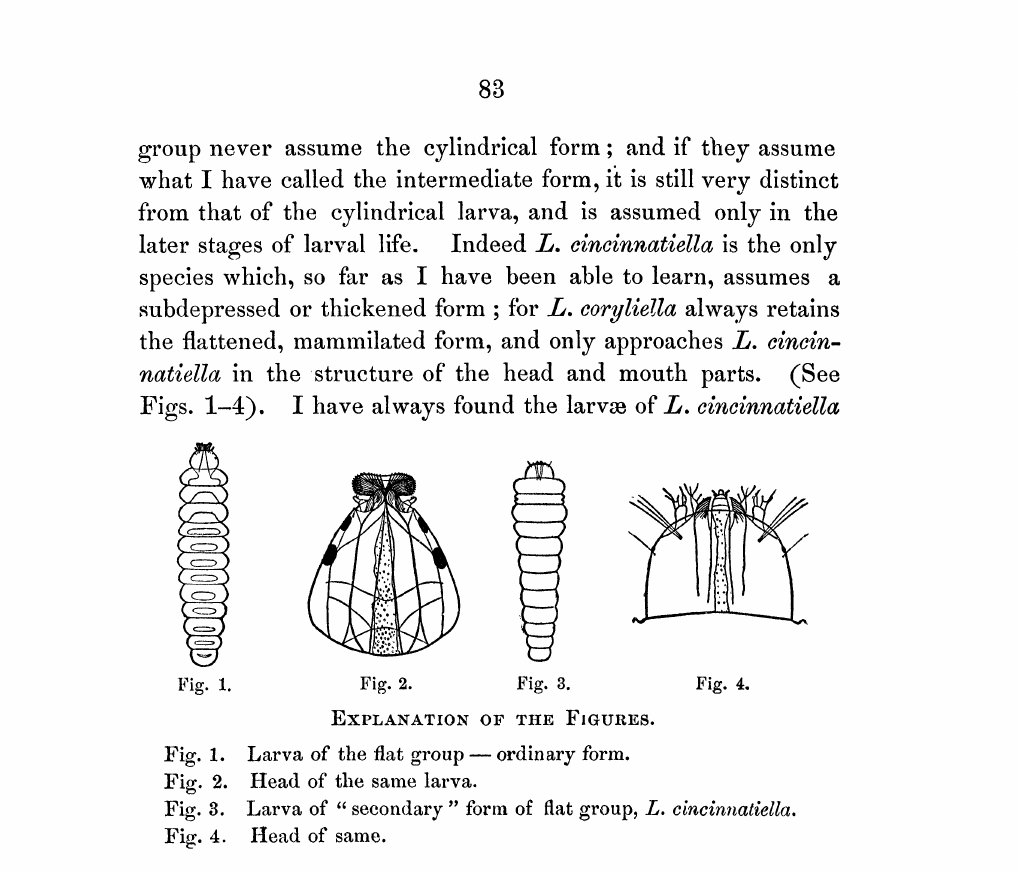
Larva of the flat group- ordinary form. Head of the same larva. Larva of secondary" form of flat group, L. cincinnatiella. Head of